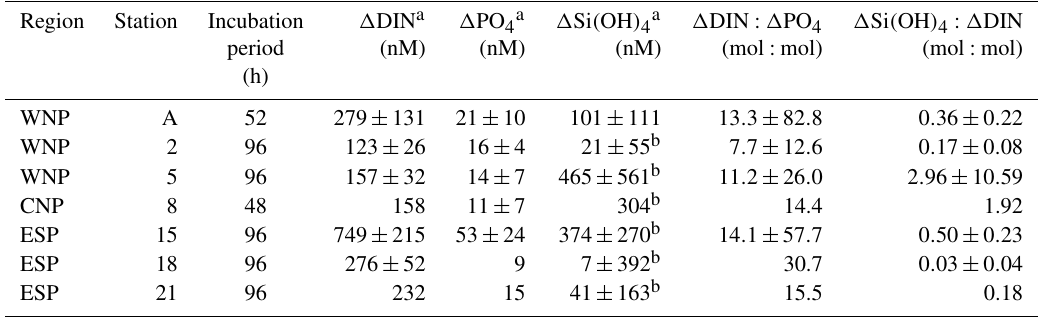
Table 3. Nutrient drawdowns and their ratios throughout the incubation periods. Errors represent 95% confidence intervals. No error means no triplicate data set.